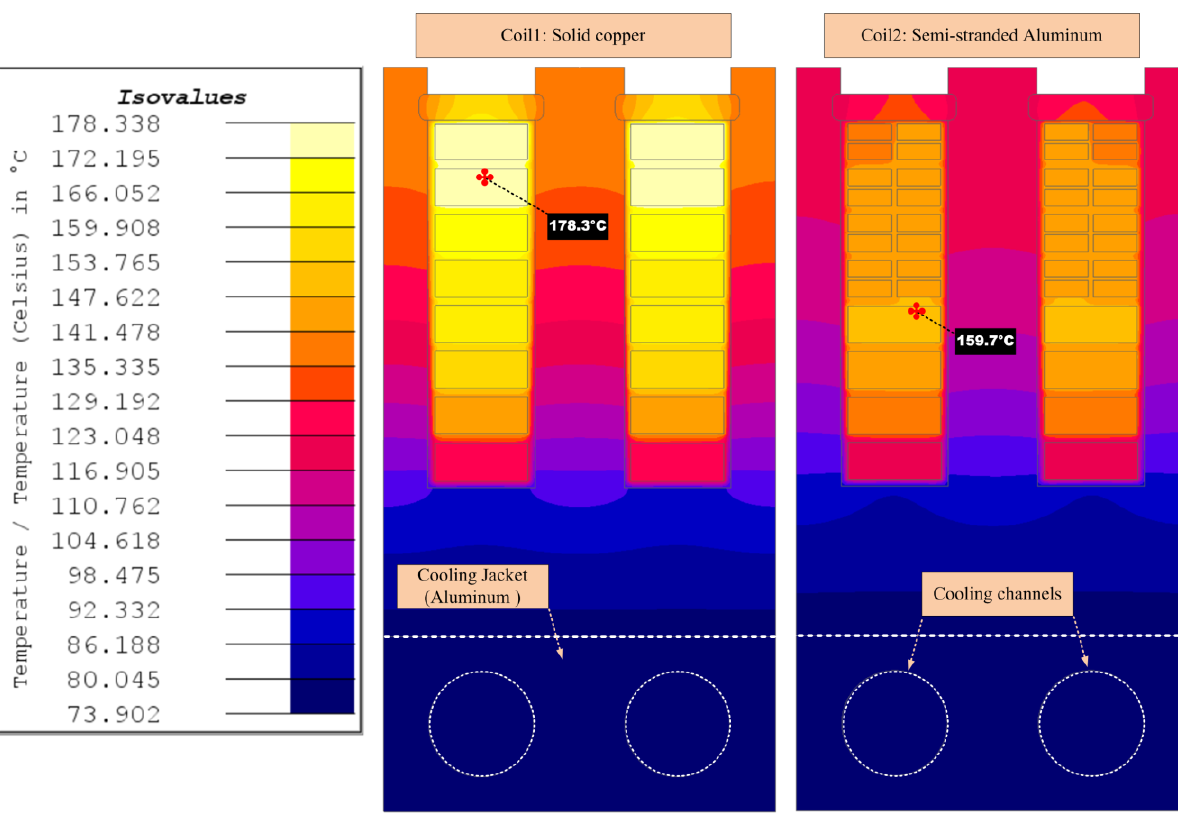
Figure 8. Comparison between the thermal profile at the worst case scenario under the same cooling conditions.